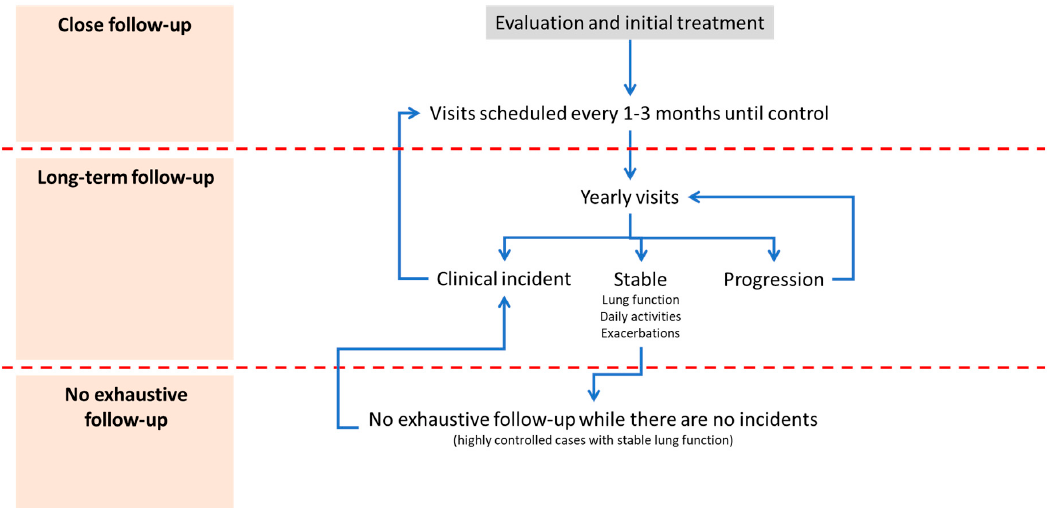
Figure 3. Different stages of monitoring the patient with COPD. Figure 3. Di ff erent stages of monitoring the patient with